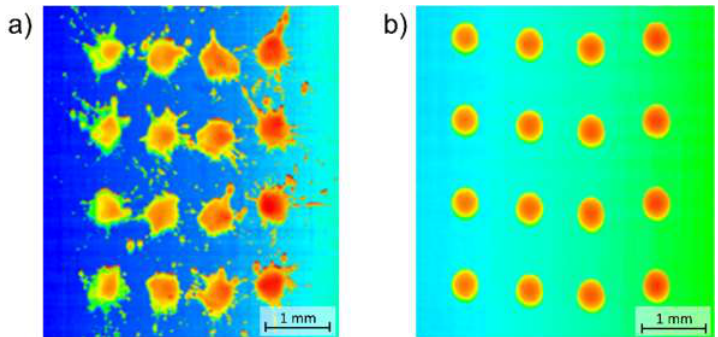
Figure 5. Comparison of the target parameters (drop height, circularity, number of satellite particles, and associated standard deviations) for the droplets produced: ( a ) poor circularity and a high amount of satellite particles or ( b ) good circularity and a low amount of satellite particles.